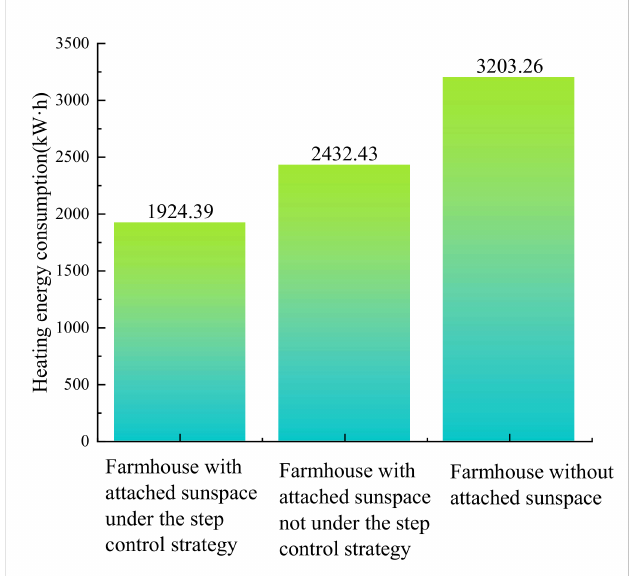
Figure 15. Energy consumption of farmhouse in heating season under different operating